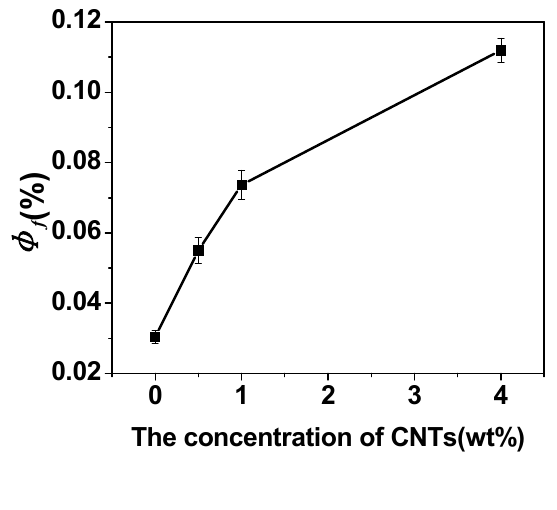
Figure 9. Fraction of the fractured bonds on a strain of 0.5 during the first compressive loading cycle as a function of the concentration of